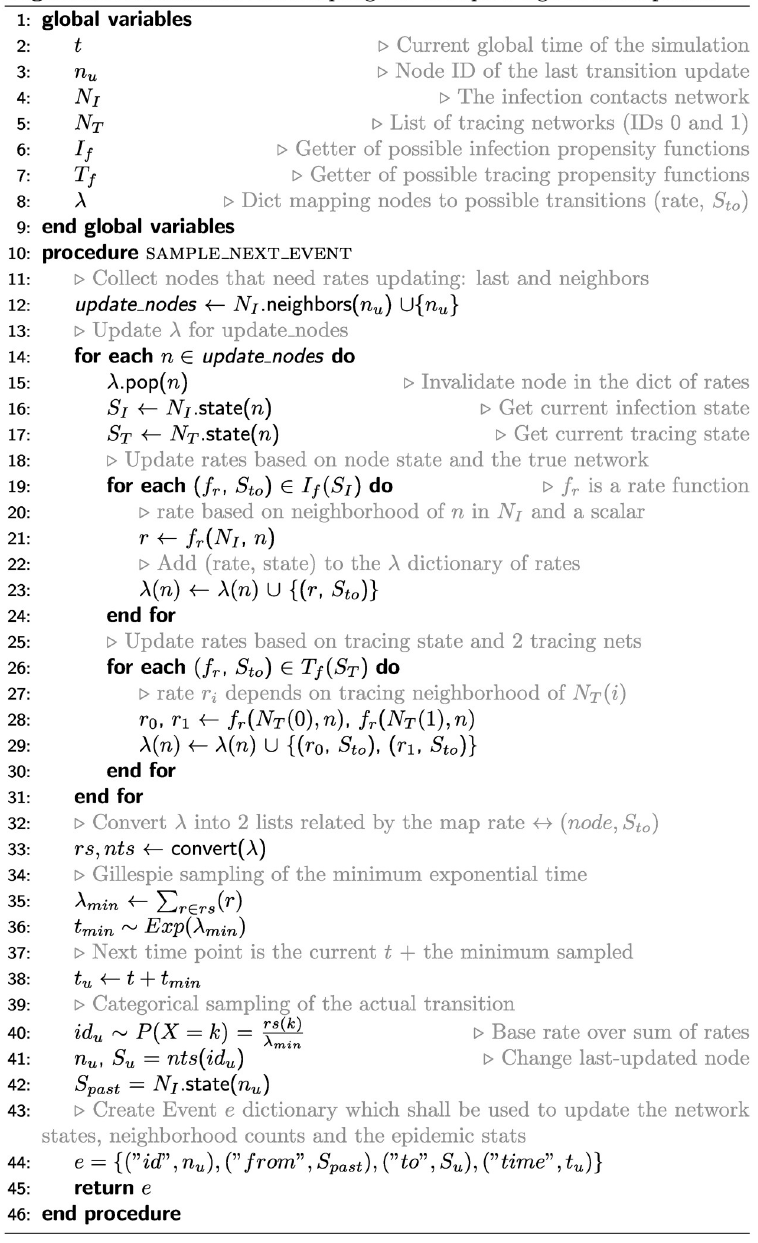
Fig 4. Pseudocode for event sampling in the SEIR-T model. We adapt Gillespie’s algorithm for our network-based simulations, thus sampling the minimum event time directly. The list of rates is updated at each iteration only for the last updated node and its neighbors. The procedure returns an event dictionary which is then used to update the network states, neighbor counts and running